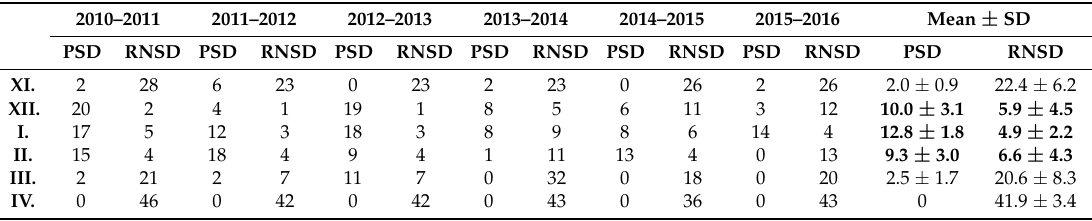
Table 3. The number of potential snowmaking days (PSD) when the daily average temperature reached the threshold of − 2 °C, the required number of snowmaking days (RNSD), and six-season mean monthly values with standard deviation (Mean ± SD). Mean monthly values in bold identify a positive difference between PSD and RNSD.